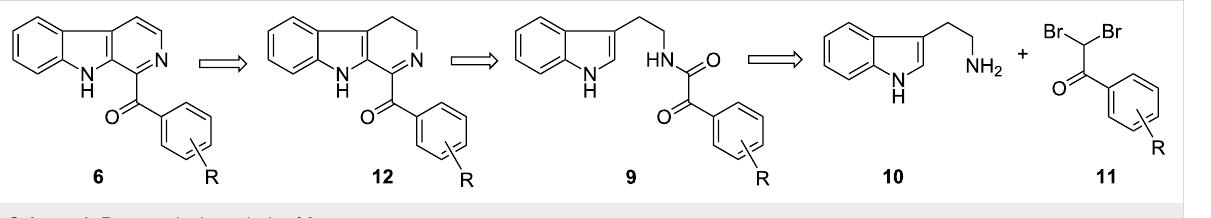
Scheme 1: Retrosynthetic analysis of 6